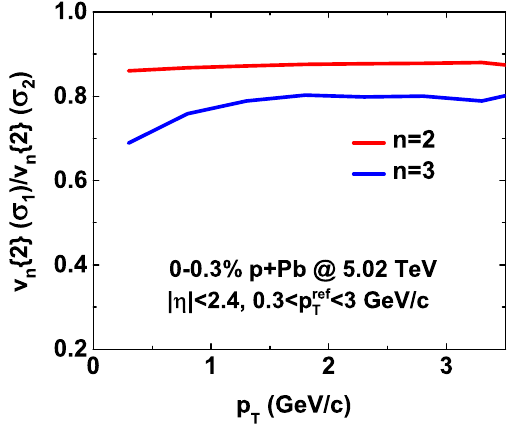
Fig. 8 The ratio between v 2 (and v 3 ) with σ = 0 . 55 fm and with σ = 0 . 45 fm as a function of p T in 5.02 TeV p + Pb collisions with same parameters and at 0-1% centrality